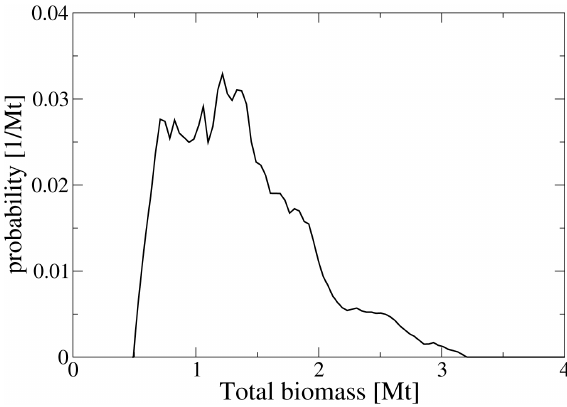
Fig. 6. Asymptotic total biomass attractor (distribution) for North (B) predicted by the SPAM model. Sea sandeel stocks P ∞ NS